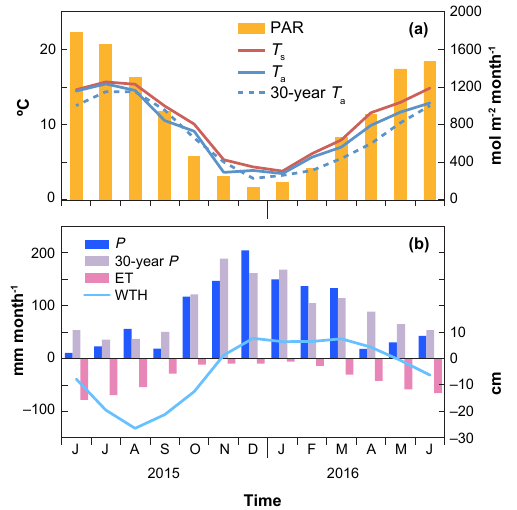
Figure 2. The annual course of weather variables ( T a , T s , P , and PAR), ET, and WTH. The 30-year climate normals (30-year T a and P ) were measured at Vancouver International Airport (data: Envi- ronment